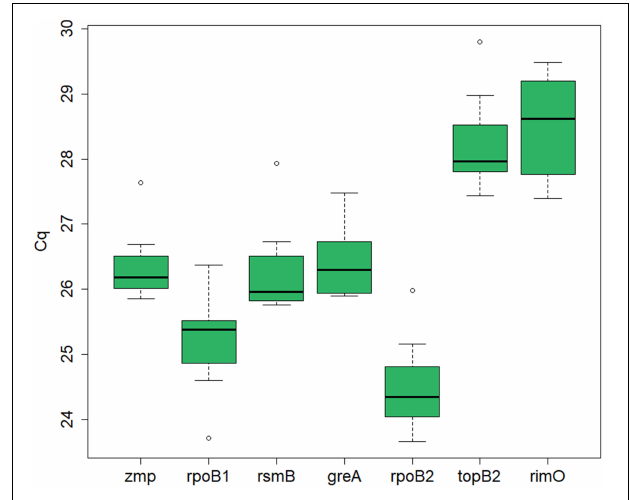
FIGURE 1 | RT-qPCR Cq values for the candidate reference genes in C. beijerinckii NRRL B-598. Depicted is the median Cq value calculated for each candidate reference gene across all samples. The boxes indicate the 25th and 75th percentiles and the error bars indicate the maximum and minimum values gained across the samples for each